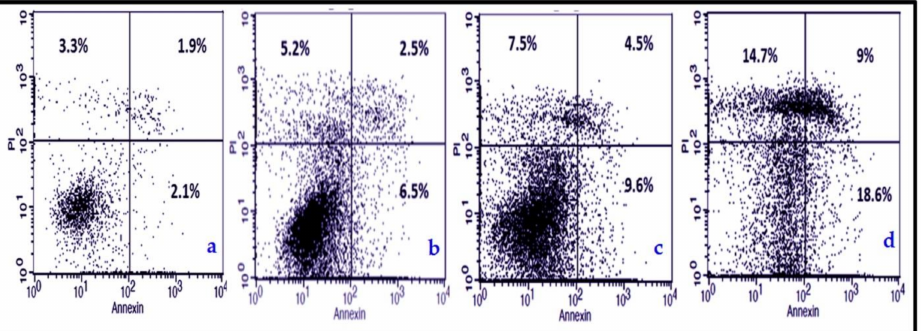
Figure 7. Cell death percentage induced by Nm E in HepG2 cells: ( a ) Ctrl. HepG2, ( b ) Nm E (6.25